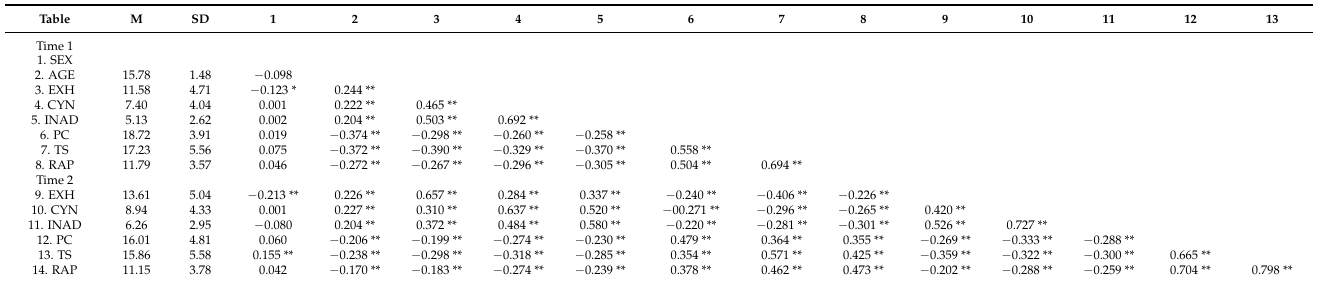
Table 1. Descriptive statistics and correlation matrix.